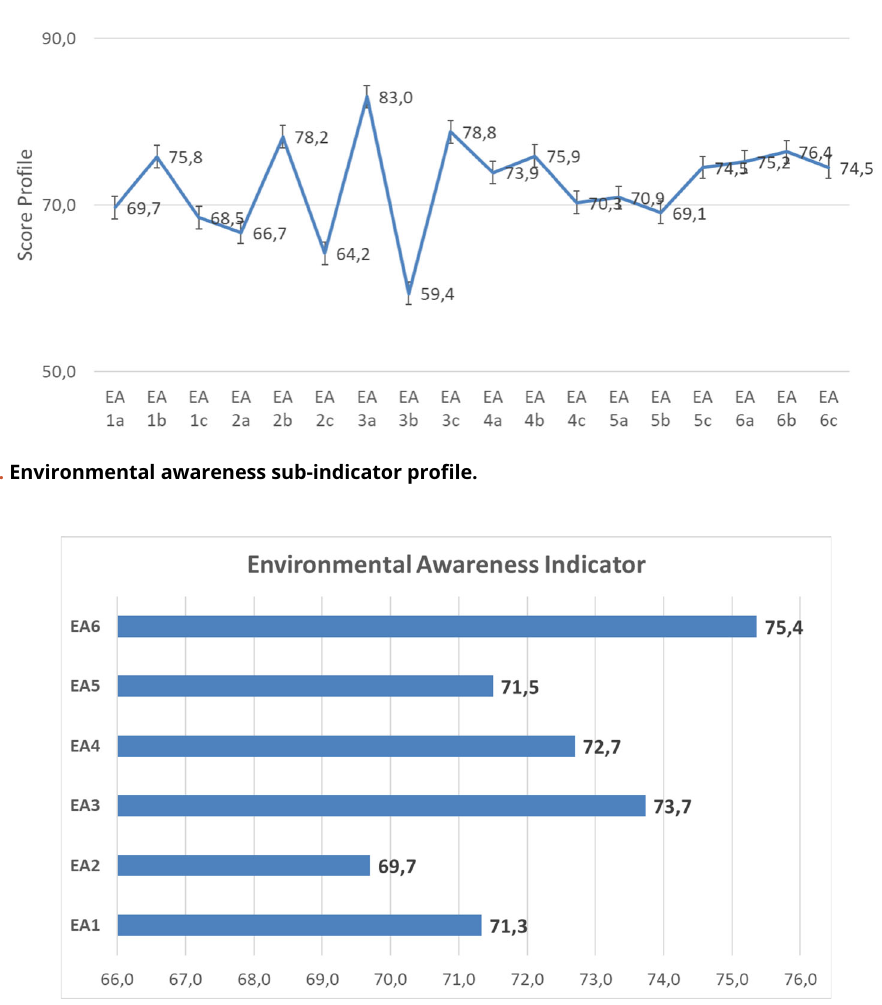
Figure 5. Environmental awareness indicator